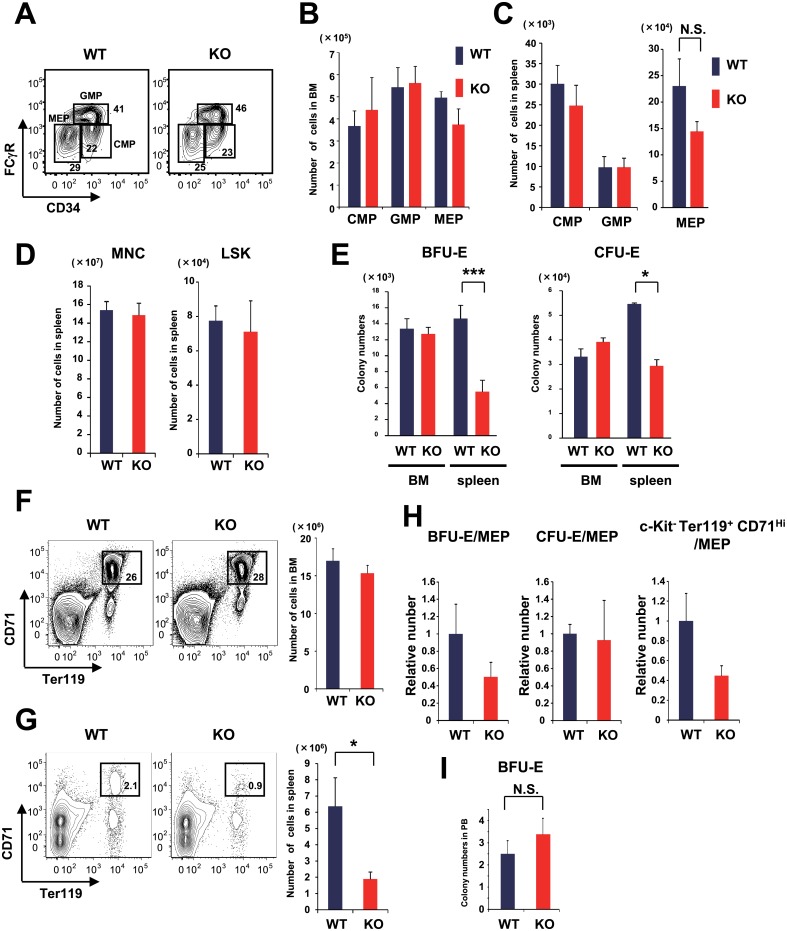
ESAM deficiency caused reduced erythropoiesis potential in the spleen, but not in the BM.WT and ESAM-KO mice were sacrificed, and flow cytometry (FACS) analyses or methylcellulose colony cultures were performed. (A) The representative FACS profiles of the Lin- IL-7Rα- c-Kit+ Sca1- fraction of WT and ESAM-KO BM cells are shown. Each number indicates the percentage of FCγRLo CD34+ CMP, FCγRHi CD34+ GMP, or FCγRLo CD34- MEP population within the Lin- IL-7Rα- c-Kit+ Sca1- fraction. (B) The numbers of CMPs, GMPs, and MEPs in the BM are shown (n = 5 in each). (C) The numbers of CMPs, GMPs, and MEPs in the spleen are shown (n = 4 in each). (D) The number of total mononuclear cells (MNC) and LSK cells in the spleen are shown (n = 4 in each). (E) BM cells and splenocytes were subjected to methylcellulose colony formation assays for counting BFU-E and CFU-E. Each bar represents the number of BFU-E (left panel) or CFU-E (right panel) in the BM and spleen (BM; n = 6 in each, spleen; n = 5 in each). (F-G) Representative FACS profiles of c-kit- fractions of BM cells (F) and splenocytes (G) from WT and ESAM-KO mice are shown. In the panels, each number indicates the percentage of the Ter119+ CD71Hi population in the c-Kit- fraction. The numbers of c-Kit- Ter119+ CD71Hi cells in the BM and spleen are shown in the right graphs (n = 5 in each). (H) The relative numbers of BFU-E, CFU-E, and c-Kit- Ter119+ CD71Hi progenitors divided by the number of MEP in WT or ESAM-KO mice’s spleen are shown. (I) The number of BUF-E in nucleated cells derived from 100 μL of PB is shown (n = 4 in each). The blue bars represent the results for the WT mice, and the red bars represent those of ESAM-KO mice. Data are from one of two independent experiments that gave similar results. Data are shown as mean ± SEM. Statistically significant differences are represented by asterisks (*P < 0.05, **P < 0.01, *** P < 0.001).